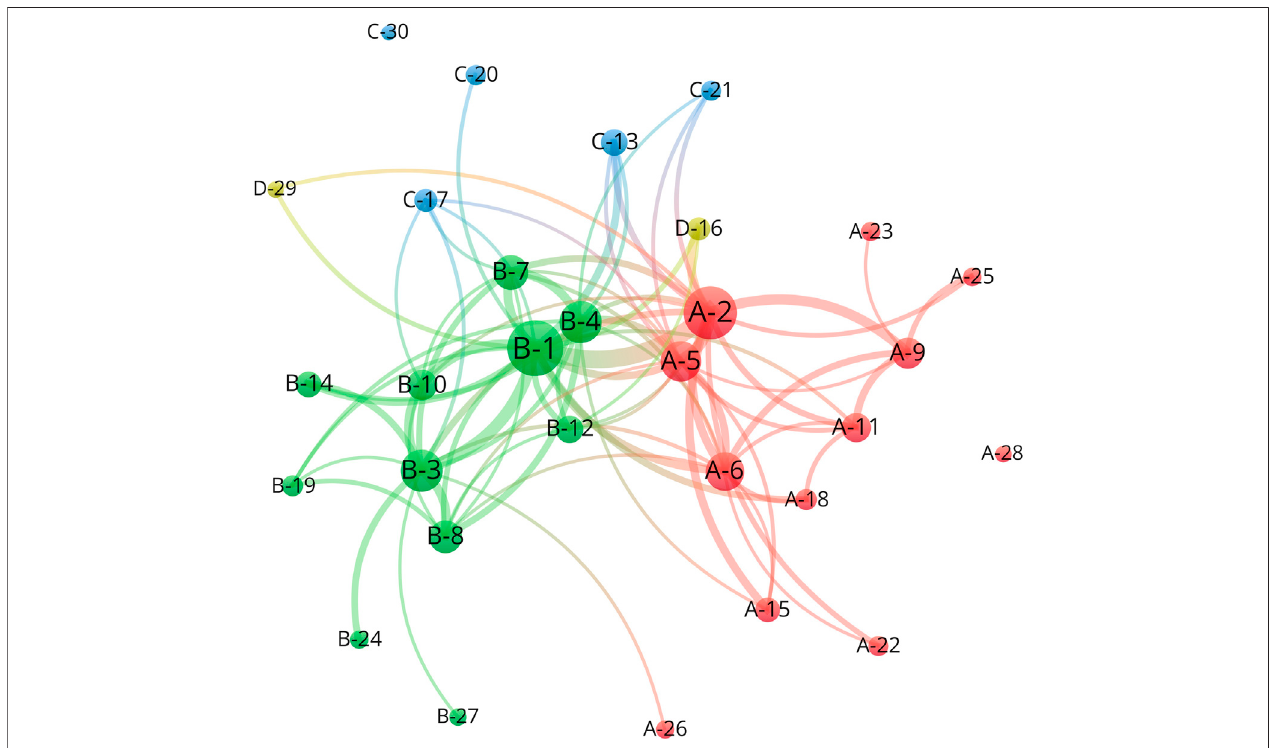
Frontiers in Environmental Science |